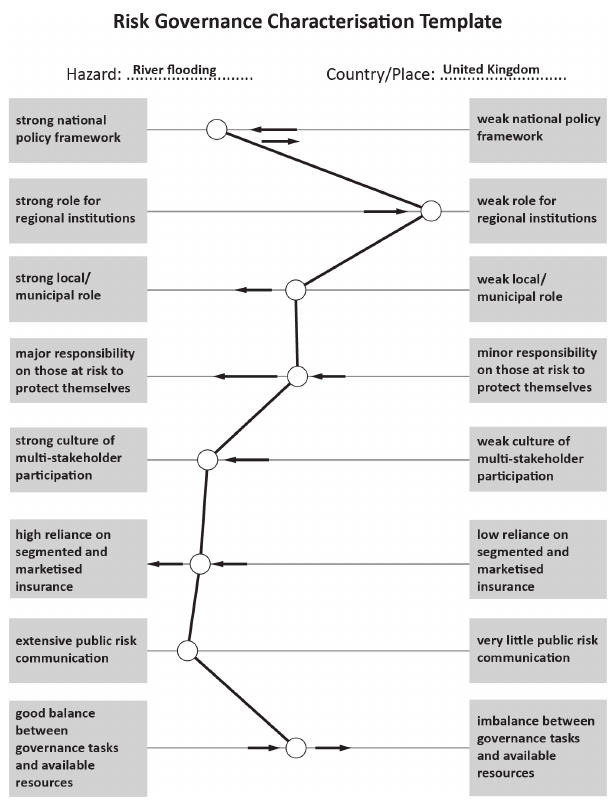
Fig. 7. Example of risk governance profile – River flooding in the